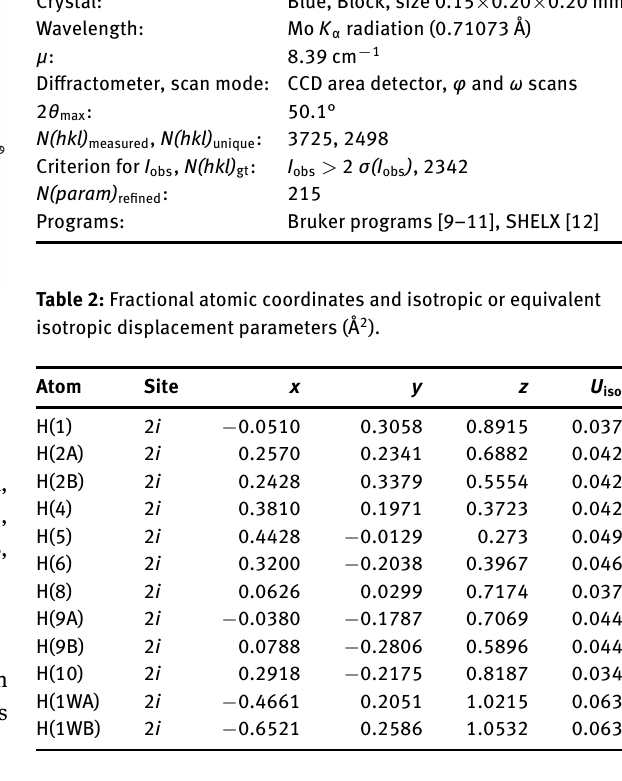
Table 1: Data collection and handling. Crystal: